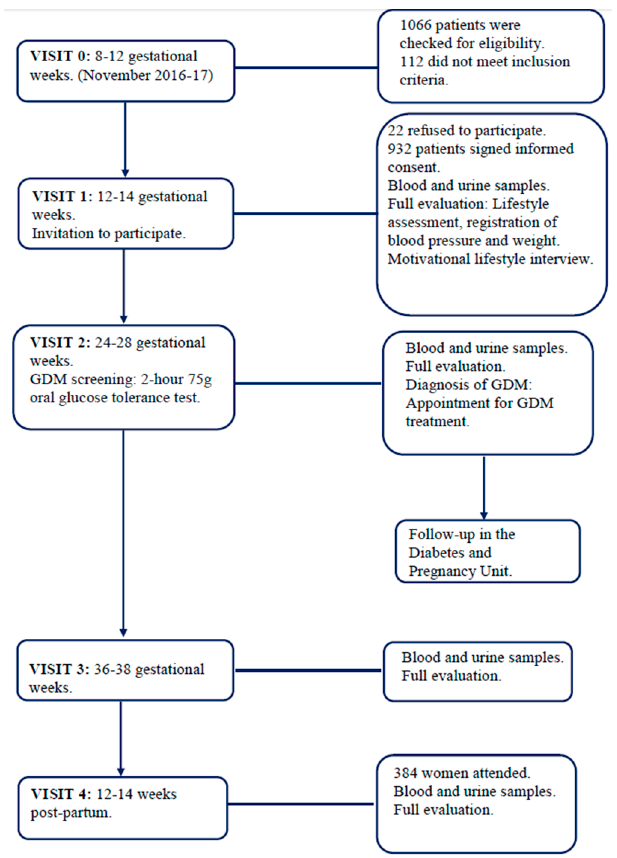
Figure 1. Flow chart of the study conduct.